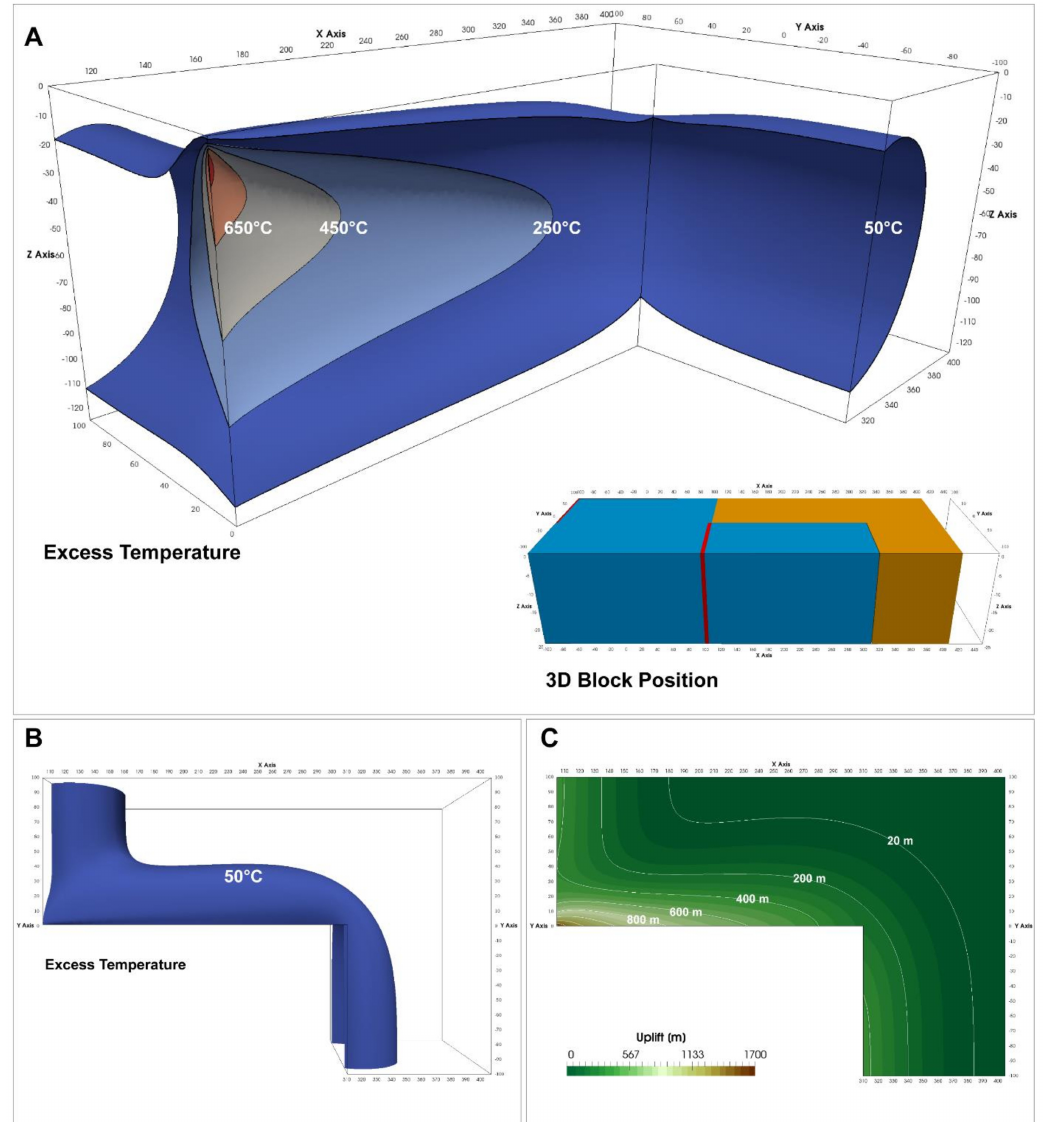
Figure 6. Thermal state of the continental block at the end of Stage A (20.5 Myr). ( A ) Side view of excess temperature contour surfaces within the continental lithosphere with a 200 ◦ C stepping. Inset shows the position of the 3D marker block. ( B ) Map view of the 50 ◦ C excess temperature contour surface. ( C ) Uplift experienced by the continental lithosphere at the end of Stage